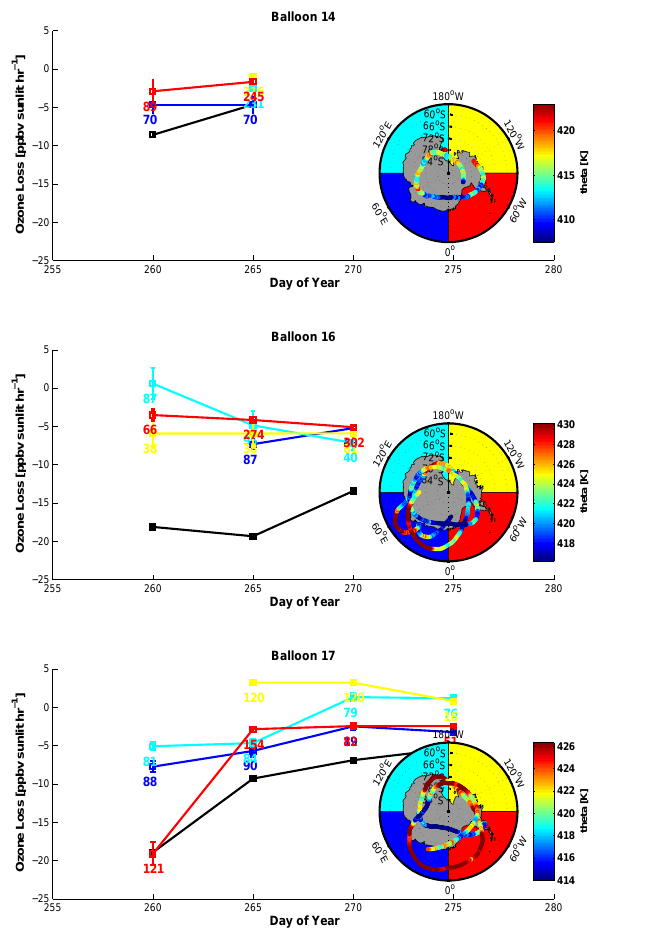
Figure 4. As Fig. 3 but for ozone loss per